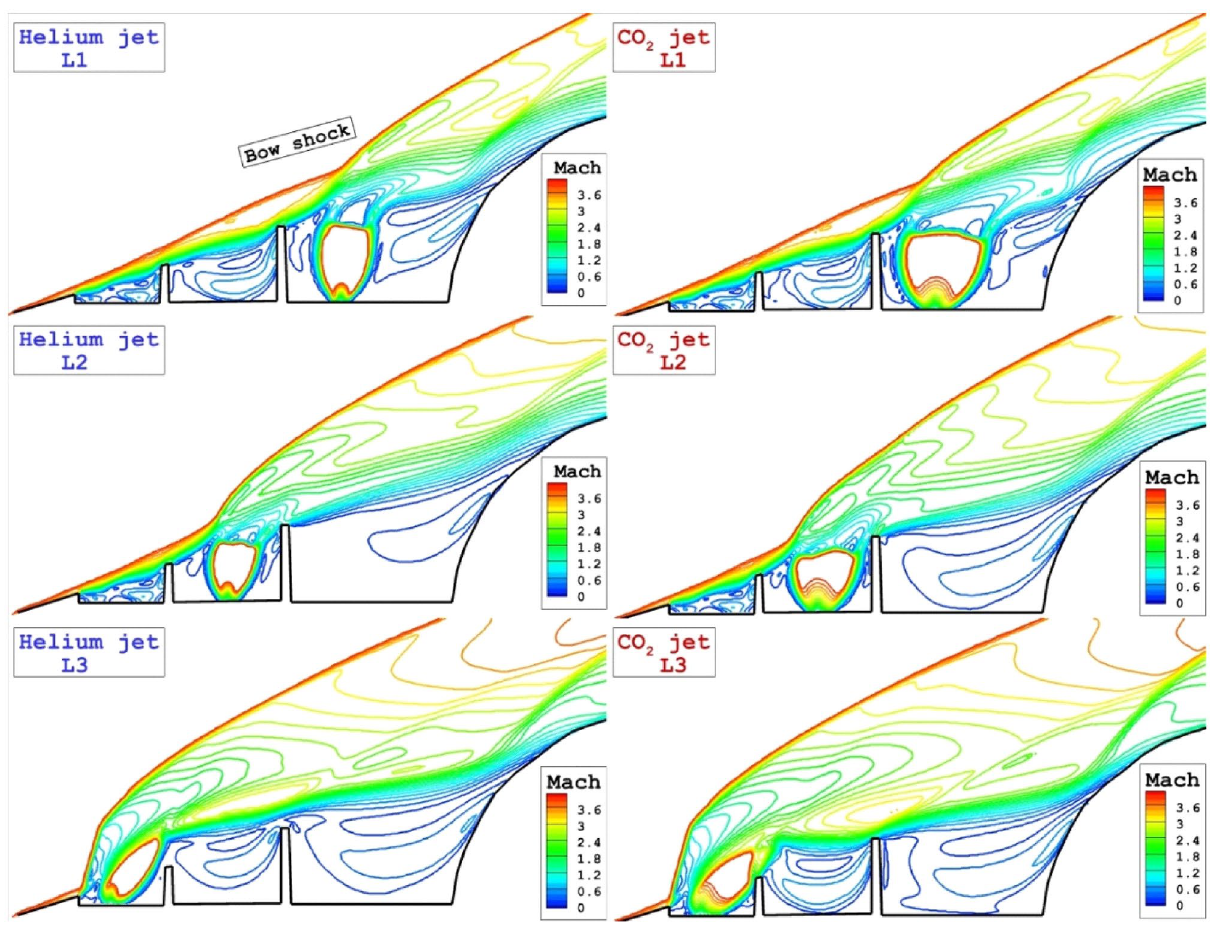
Figure 5. Influence of the different lateral coolant injection systems on shock